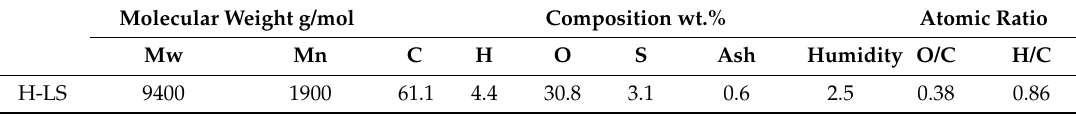
Table 1. Specifications of